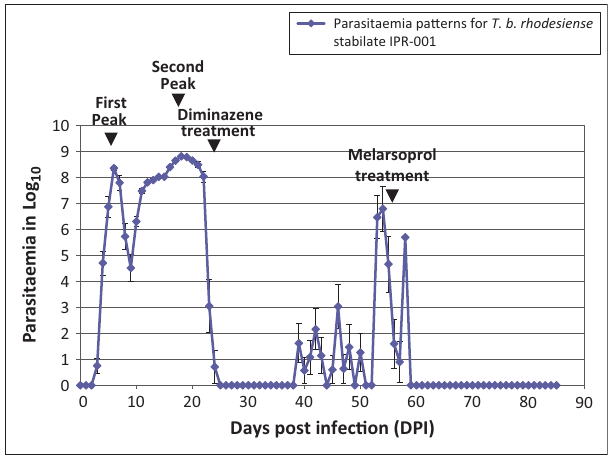
FIGURE 3: Mean parasitaemia pattern for T. b. rhodesiense IPR-001 infection in FIGURE 4: Mean survival for ILRI-2918, ILRI-3953 and IPR-001 infected mice. Swiss white mice. The first peak occurred at six DPI; the second peak occurred In ILRI-2918 infected mice, survival was 100 % until after treatment with at 18 DPI. Mean parasitaemia at the first peak was estimated at Log 8.36. diminazene aceturate at 21 DPI, whereupon 50 % developed hindleg paresis and 10 Mean parasitaemia at the second peak was estimated at Log 8.81. Following were euthanised with the rest of the population succumbing to the parasite 10 treatment at 21 DPI with diminazene aceturate (40 mg/kg i.p., Berenil®, after parasitaemia relapse. In ILRI-3953 infected mice, mortality was 100 % Intervet, South Africa), parasitaemia dropped below microscopically-detectable by 10 DPI. In IPR-001 infected mice, survival was 97 % before treatment with levels between 22 and 25 DPI. Relapse parasitaemia was observed to occur at diminazene aceturate at 21 DPI, dropping and stabilising at 38 % (24–31 DPI), 39 DPI (Log 1.62) and peaked at 54 DPI (Log 6.8). Following treatment with followed by 35 % (32–44 DPI), then 31 % (45–56 DPI) and finally stabilising after 10 10 melarsoprol (3.6 mg/kg ip, Arsobal®, Sanofi-Aventis, Paris, France), parasitaemia treatment with melarsoprol to 27 % (57–79 DPI). All mice surviving after the was again observed to drop below microscopically-detectable levels until the treatment were termination of the experiment at 86 DPI.